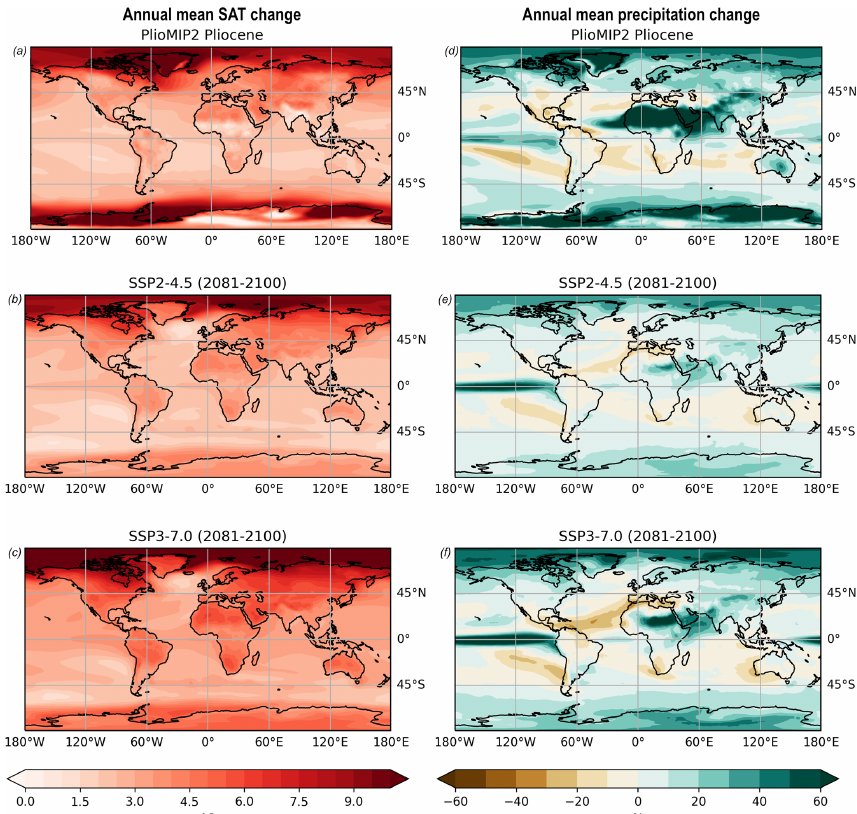
Figure 1. PlioMIP2 ensemble MIS KM5c SAT (a) and precipitation (d) anomalies relative to the PI compared to equivalent CMIP6 anoma- lies for 2081–2100 under SSP2-4.5 (b, e) and SSP3-7.0 (c, f) . The PlioMIP2 ensemble includes all 16 models in Haywood et al. (2020) plus HadGEM3 (Williams et al., 2021). The CMIP6 data are from the IPCC WGI Interactive Atlas (Gutiérrez et al., 2021). CMIP6 SAT anomalies (b, c) are relative to 1850–1900, and precipitation anomalies (e, f) are relative to the standard CMIP6 base period (1995–2014). Note that the models included in PlioMIP2 are not all included in